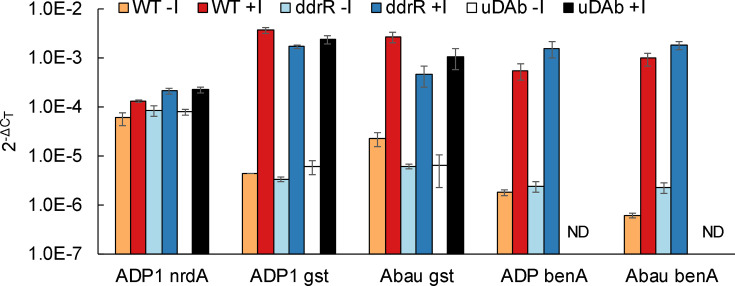

ddrR mutation does not affect the induction of genes that are not regulated by UmuDAb. RT-qPCR experiments measured the expression of genes (ACIAD0724 nrdA, ACIAD0445 gst or ACIAD1436 benA in ADP1; A1S_0408 gst or A1S_1215 benA in 17978) in un-induced (-I) and induced (‘+I’ for inclusion of inducing agent: MMC for nrdA and gst; or benzoate for benA) conditions for WT, ddrR and umuDAb strains of ADP1 and 17978. There was no significant difference in the induction level of any of these genes in the ddrR or umuDAb mutants (P>0.05; in a two-tailed t
-test) after MMC or benzoate exposure (for benA gene expression only). nd
, benA expression was not examined (not done) in umuDAb mutants of either 17978 or ADP1 by RT-qPCR, although previous experiments have shown that benzoate-mediated induction of benA is unaffected by the umuDAb mutation [18]. Each gene was assayed in one RT-qPCR experiment (plate), with error bars indicating the standard error of the mean from technical triplicates of biological triplicates.